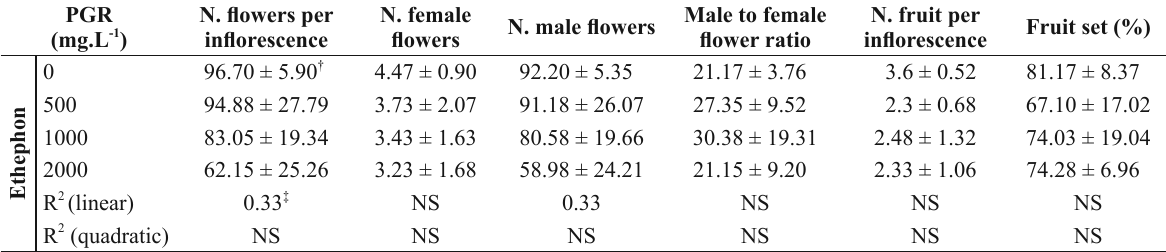
Effects of ethephon (Florel ® ) and BA + GA (Promalin ® ) concentrations on fl owering variables (mean + SD) 4+7 of Jatropha curcas L. plants with leaves.